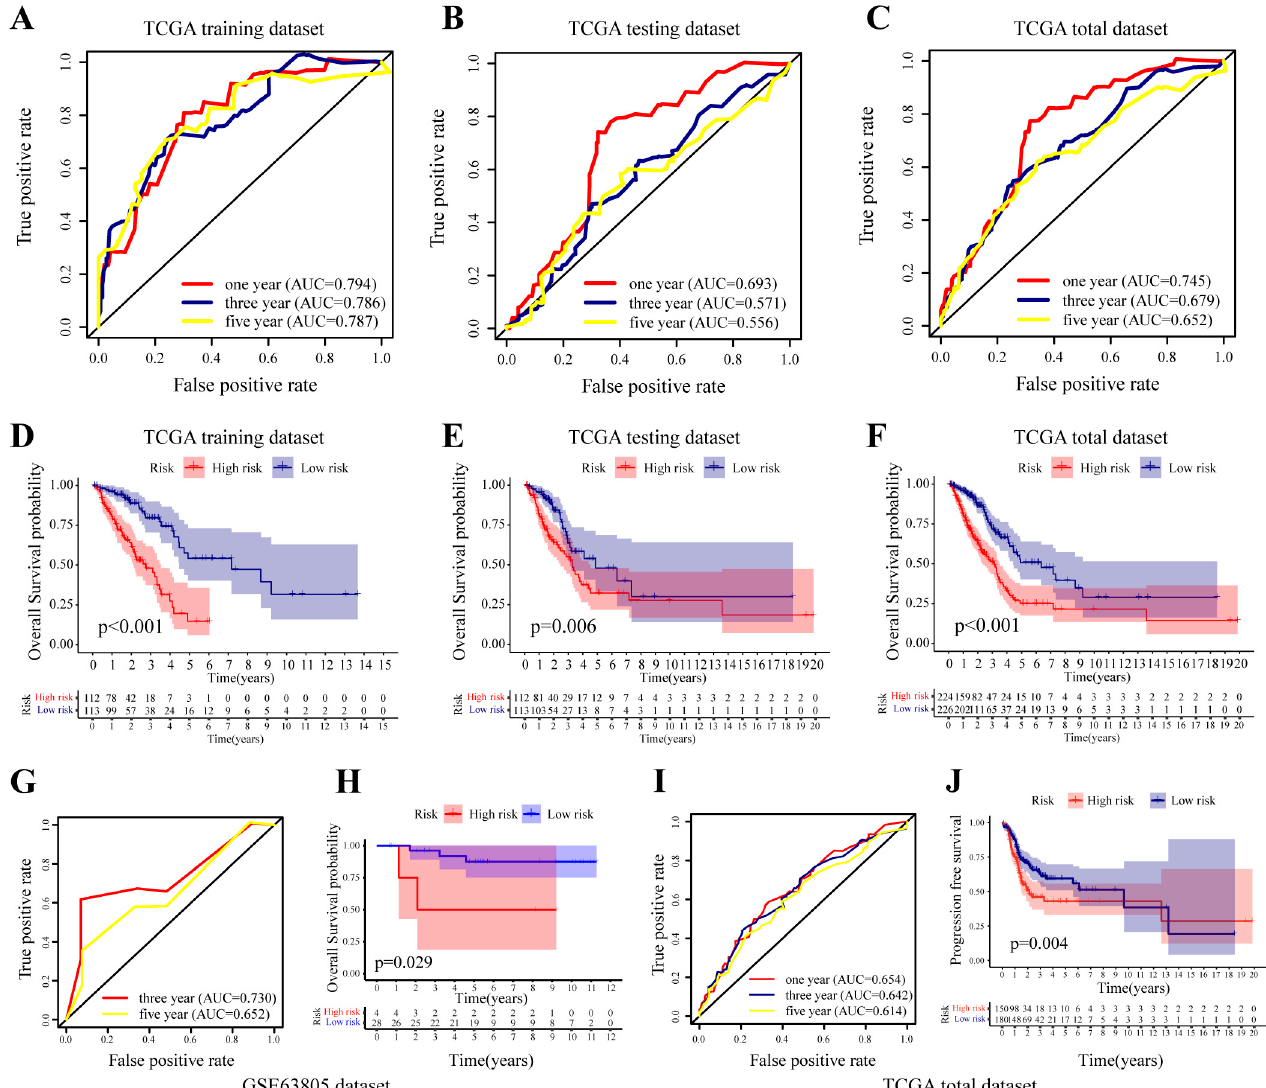
Figure 3. Evaluation and validation of the prognostic model. Receiver operating characteristic (ROC) curves for overall survival (OS) of ( A ) TCGA training dataset, ( B ) TCGA testing dataset, ( C ) TCGA total dataset, ( G ) GSE63805 dataset. Kaplan–Meier OS analysis of ( D ) TCGA training dataset, ( E ) TCGA testing dataset, ( F ) TCGA total dataset, ( H ) GSE63805 dataset. ( I ) ROC curves for progression-free survival (PFS) of TCGA total dataset. ( J ) Kaplan–Meier PFS analysis of TCGA total dataset.